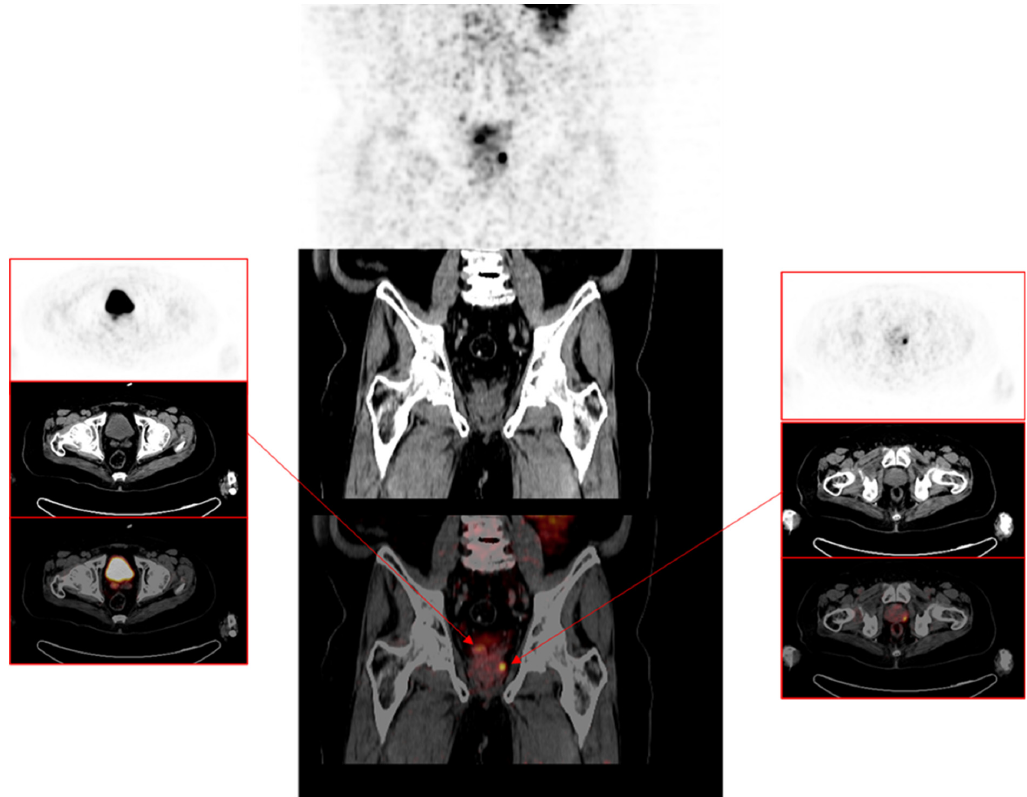
Figure 2. A 77-year-old male previously treated with external beam radiotherapy for adenocarcinoma of the prostate, Gleason 4+4. 68 Ga-PSMA-11 PET/CT was requested for the localization of disease recurrence at serum PSA of 0.61 ng/mL. Central images are the coronal PET-only, CT-only, and fused PET/CT images of the pelvis, localizing disease recurrence to the right seminal vesicle (right insert) and a focal lesion in the left lobe of the prostate gland (left insert).